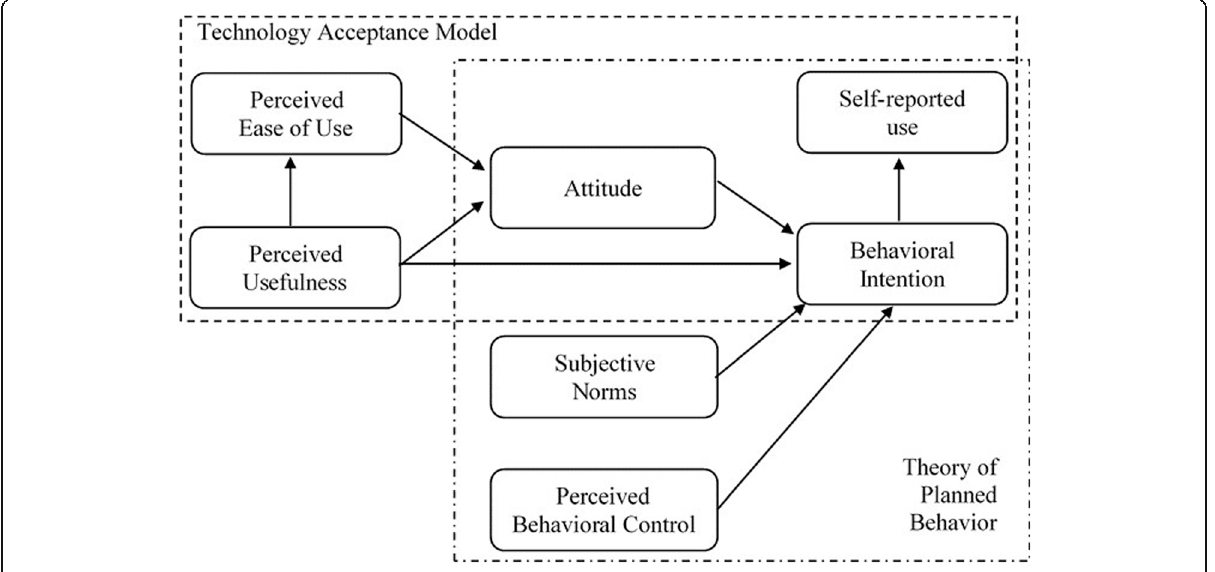
Fig. 1 Integrated TAM/TPB model. Adapted from Pynoo and van Braak (2014, p.